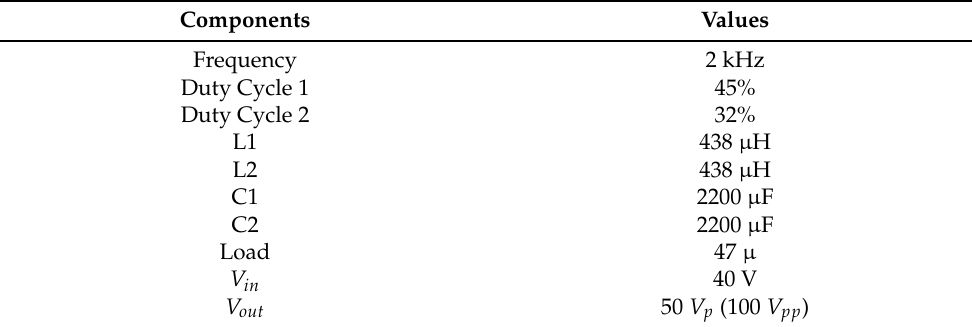
Table 1. Simulation and implementation values.